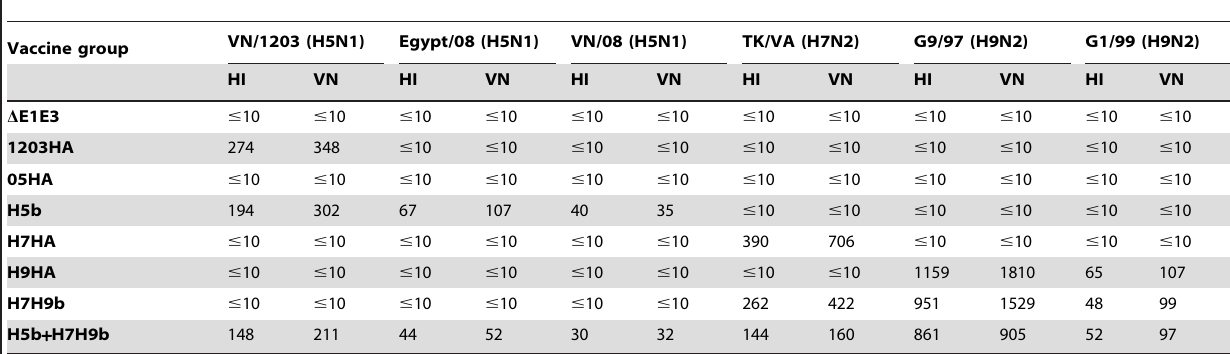
Mice (7 animals/group) were immunized with 1203HA, 05HA, H5b, H7HA, H9HA, H7H9b, H5b + H7H9b, or D E1E3 twice at four-week intervals. Four weeks post-booster inoculation, serum samples were obtained for determining virus neutralizing (VN) and hemagglutination inhibition (HI) antibody titers. The data are shown as the